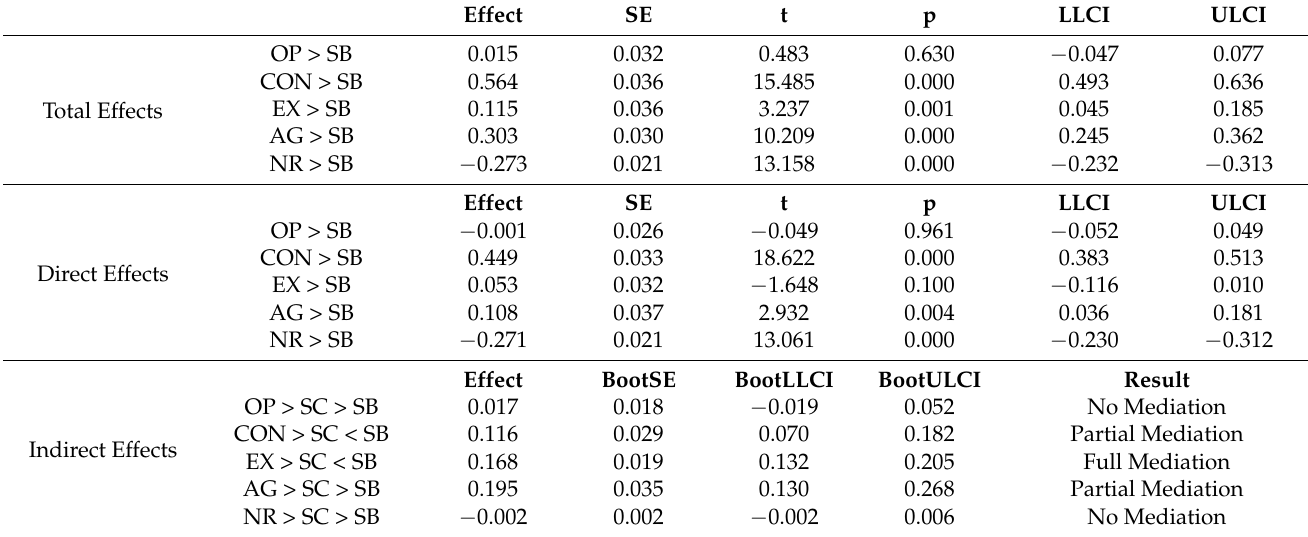
Table 5. Results of Mediation